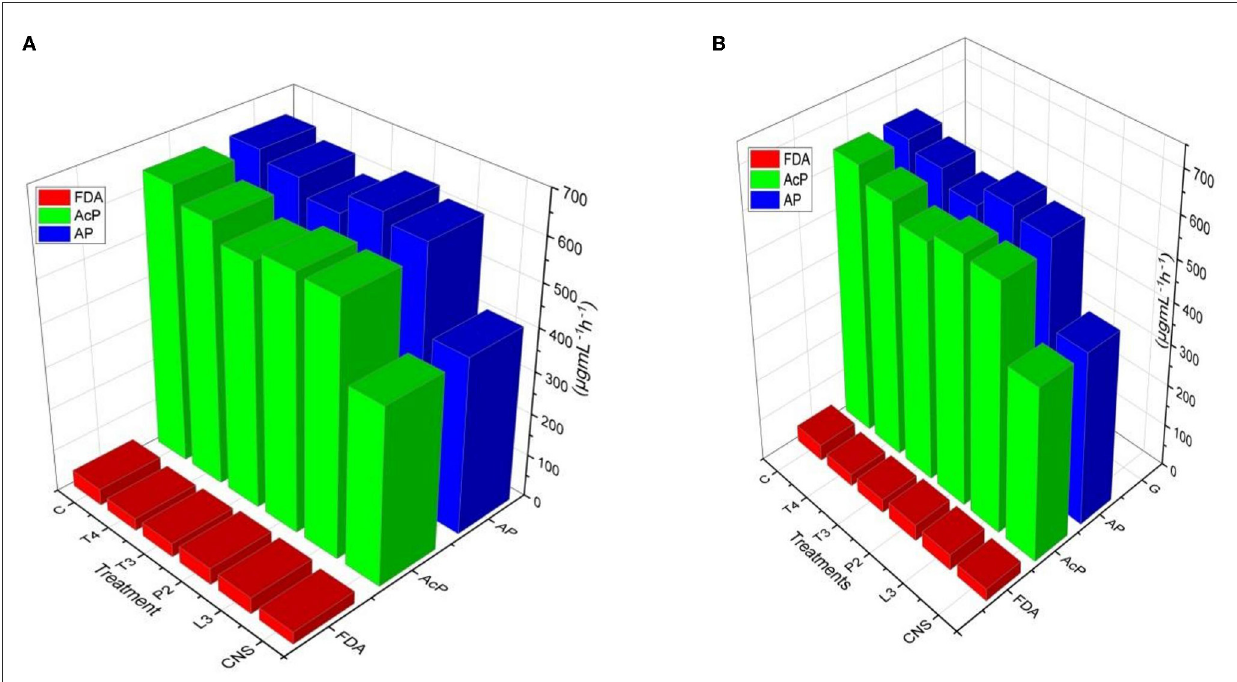
FIGURE7 Soil enzyme variation includes FDA, AP, and AcP in response to PSB inoculation under field conditions in (A) Set I and (B) Set II after final